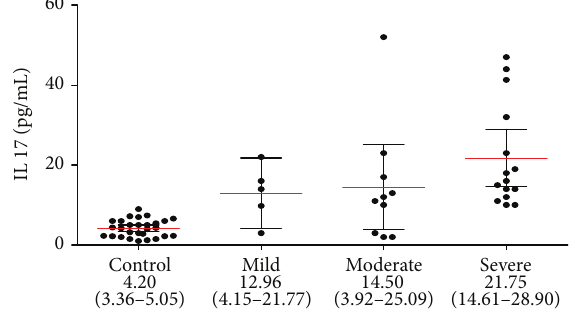
Figure 2: IL-17 concentration in serum of eRA disease patient with different clinical activity stages (black circles represent IL-17 con- centration, pg/mL in individual serum samples; red lines represent mean values accompanied by 95% confidence interval, represented as black horizontal